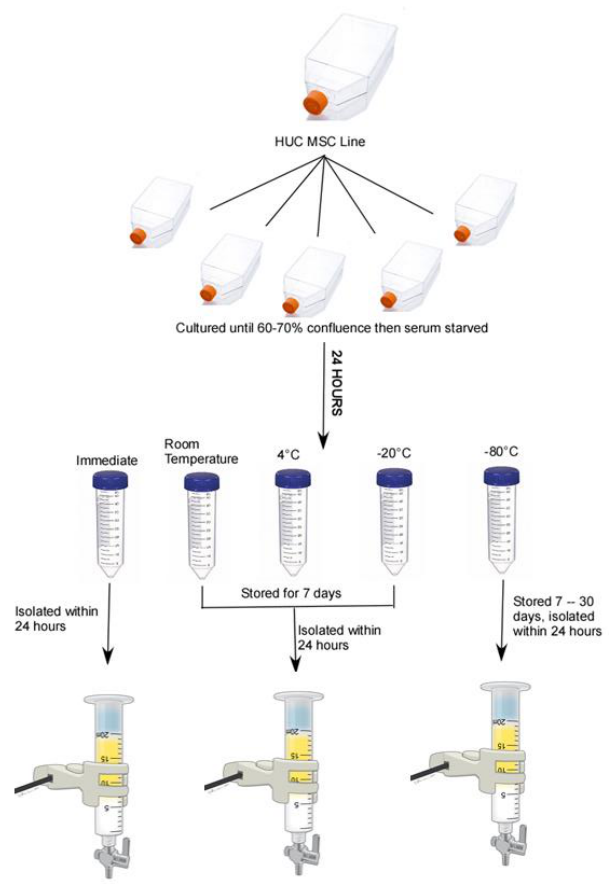
Figure 1. A schematic of the balanced experimental design showing the major steps involved for the isolation of extracellular vesicles from the human umbilical cord-derived mesenchymal stromal cell (HUC-MSC) culture-conditioned media. Following cryopreservation, HUC-MSCs were allowed one passage of recovery before being passaged and split into five T-150 tissue culture-treated flasks and incubated at 37 °C, 90% humidity, and 5% CO 2 until 60 – 70% confluence was reached. The medium was removed and replaced with a serum-free medium. After 24 h, conditioned media were collected in a sterile 50 mL centrifuge tube and randomly assigned one of the five storage conditions (immediate, room temperature, 4 °C, − 20 °C, and − 80 °C). Samples in the immediate group were isolated within 24 h by a combination of ultrafiltration and size-exclusion chromatography. Samples in room temperature, 4 °C, and − 20 °C were stored for seven days at the assigned temperature and isolated within 24 h. Samples in the − 80 °C group were stored up to one month before EV isolation.